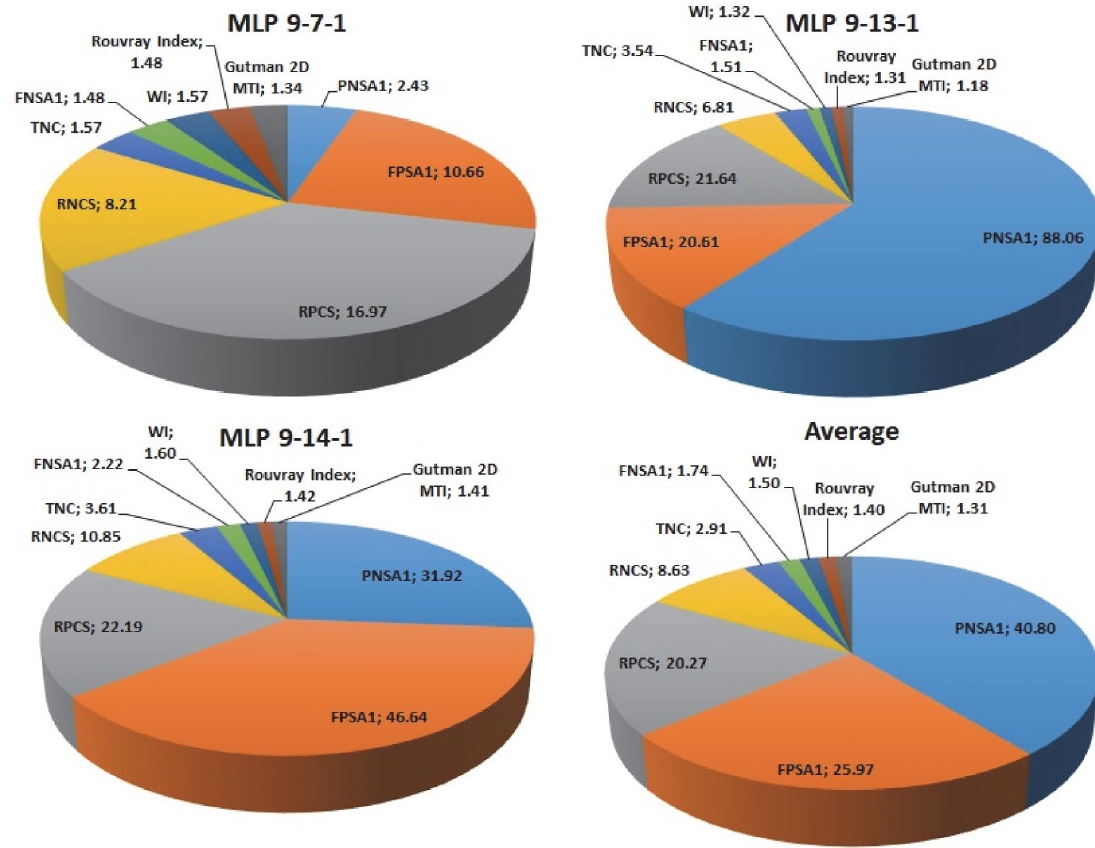
Figure 7. The GSA coefficients of the established ANNs and their average values.